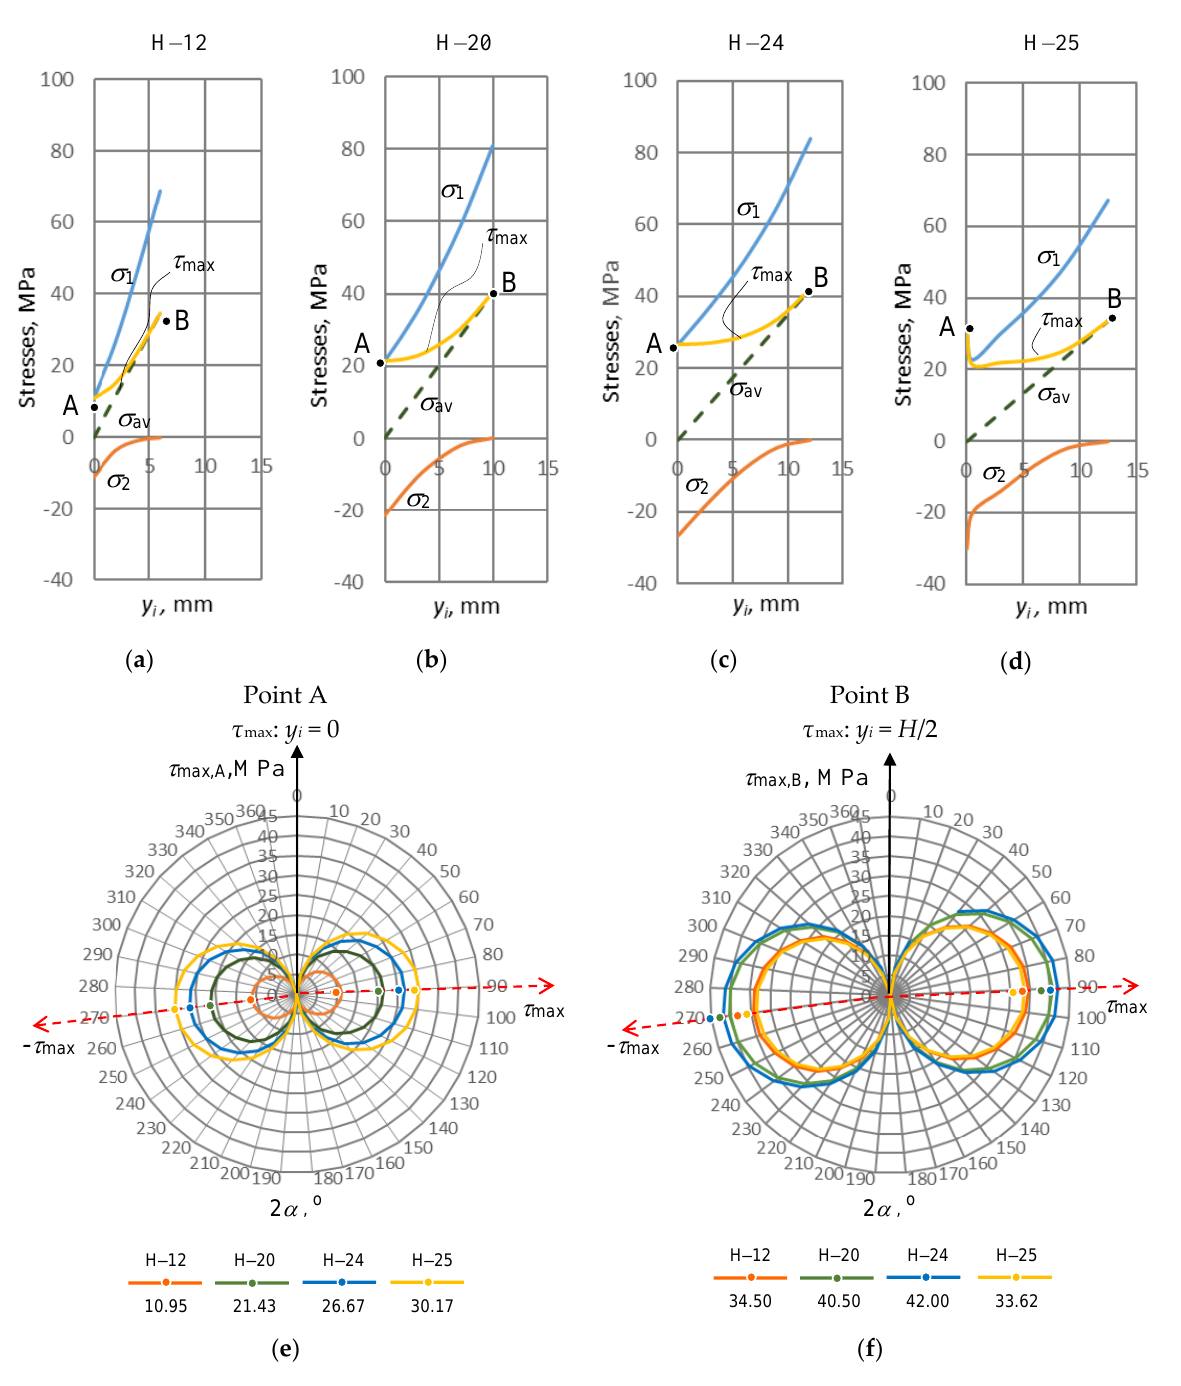
Figure 14. The representation of stresses σ 1 , σ 2 , τ max and σ av versus variable cross-sectional distance y i : ( a – d ) a set of stresses acting within the samples H − 12, H − 20, H − 24, H − 25, respectively; ( e , f ) the maximal shear stresses at point A ( τ max,A ) and Point B ( τ max,B ), respectively. The two red dashed arrows indicate the directions where the shear stresses reach extreme values | τ max |